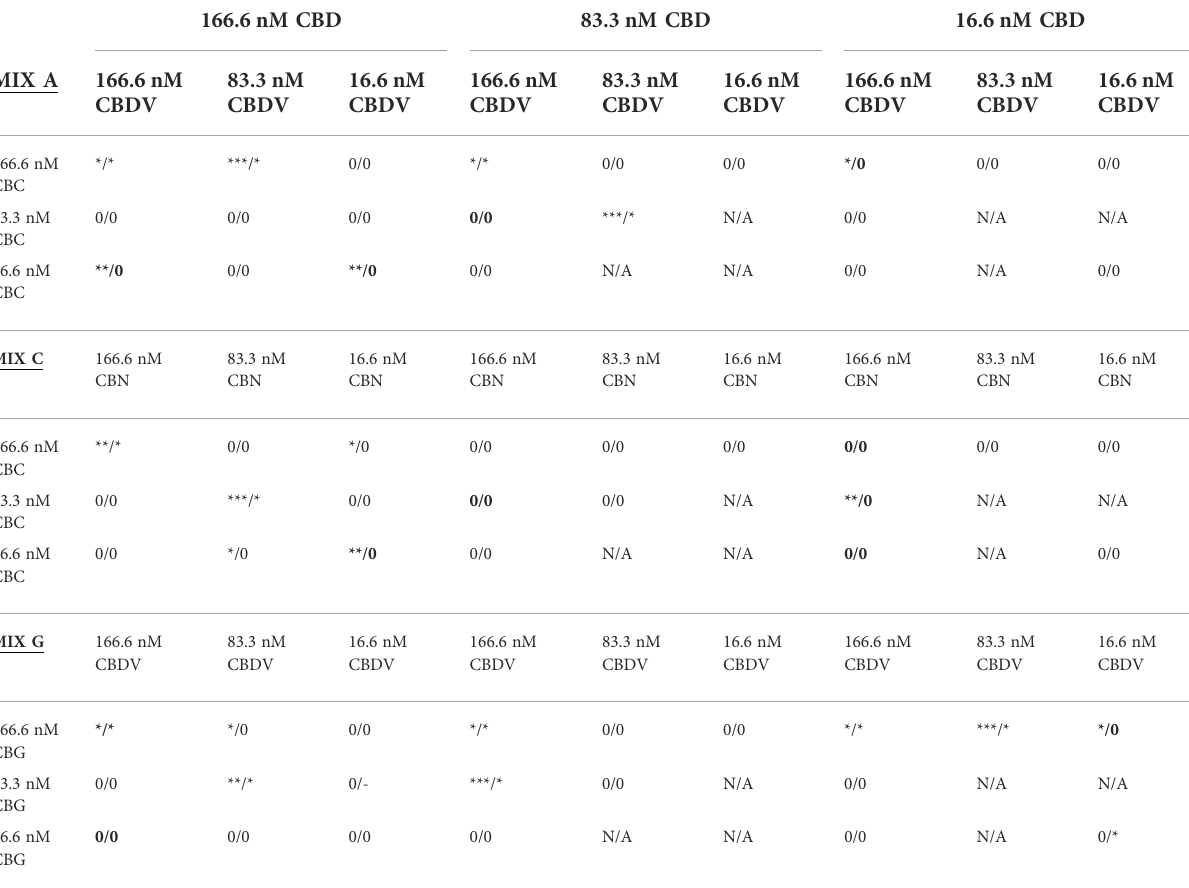
TABLE 2 Summary of Ef fi cacy of De fi ned Cannabinoid Ratio MEM activities in the OHDA assay in zebra fi sh. The concentrations of each of the three cannabinoids tested shown in each fi eld of this table are shown starting with the CBD concentration (labeled in the top row). The CBD concentration is used to divide the results table into three columns. The second cannabinoid and concentration for each ratio result is in the fi rst columnofthetableandisusedtofurtherdividethetableintoninesetsofnineresults,andthelastcannabinoidandconcentrationisabovethecellin the row containing the label of the original equimolar ratio formula. Astrices (* = p < 0.05, ** = p < 0.01, *** = p < 0.001) on either side of the “ / ” represent the level of statistical signi fi cance in change in the Total Frequency of Activity State Change metric (right-side)/Cumulative Duration metric (left-side) of zebra fi sh exposed to the MEM + OHDA versus the OHDA-alone group. Zeroes represent no statistically-signi fi cant change in activity, “ - ” indicates a further reduction (increase in PD-like symptoms, p < 0.05)) in activity. N/A = combinations not selected because of the inactivity of their precursors. Bolded cells also showed an MEM dependant increase on methanol treated control